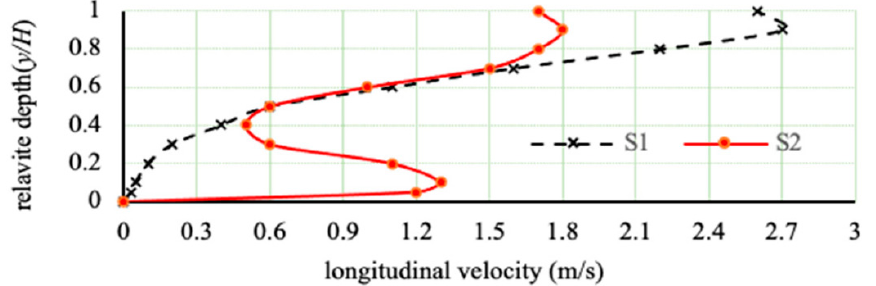
Figure 14. Velocity profiles of cross-Section 3 under the two case boundary conditions. The curve of the flow velocity profile was obtained according to the numerical simulation data in Section 3, as shown in Figure 6. It is seen that because part of the flow discharging at the weir crest is transferred to